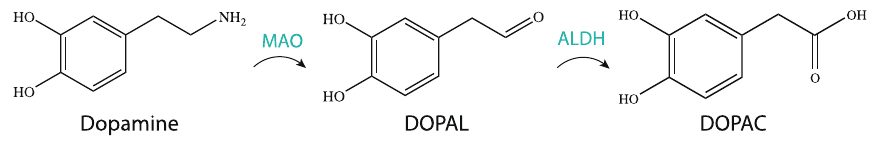
Fig. 1 Schematic of the main metabolic pathway involving DOPAL. The catecholamine neurotransmitter dopamine is oxidised into the catecholaldehyde DOPAL (3,4-dihydroxyphenylacetaldehyde) by monoamine oxidases (MAO), and further converted into the less toxic catecholic acid DOPAC (3,4- dihydroxyphenylacetic acid) by aldehyde dehydrogenases (ALDH).